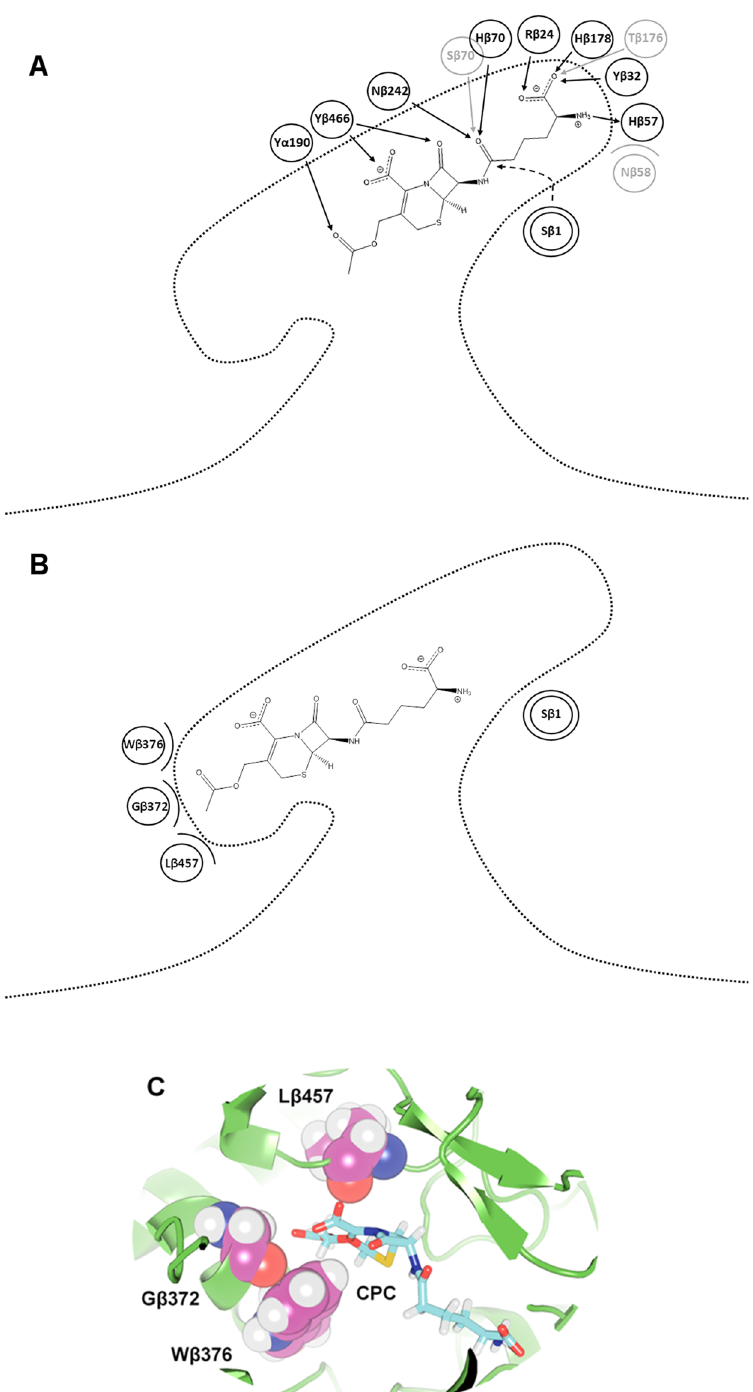
Figure 6. Representation of the CPC productive binding pose at d NAC ≈ 3.5 Å ( A ) and the non-productive binding pose into the hydrophobic trap at d NAC ≈ 9.5 Å ( B , C ). Residues interacting with CPC are indicated by circles. Additional mutations in M6 are highlighted in grey. The type of interaction is indicated by an arrow (hydrogen bonds) or by a curved line (steric interactions). The catalytic β 1 serine is indicated by double circle and its nucleophilic attack by a dashed